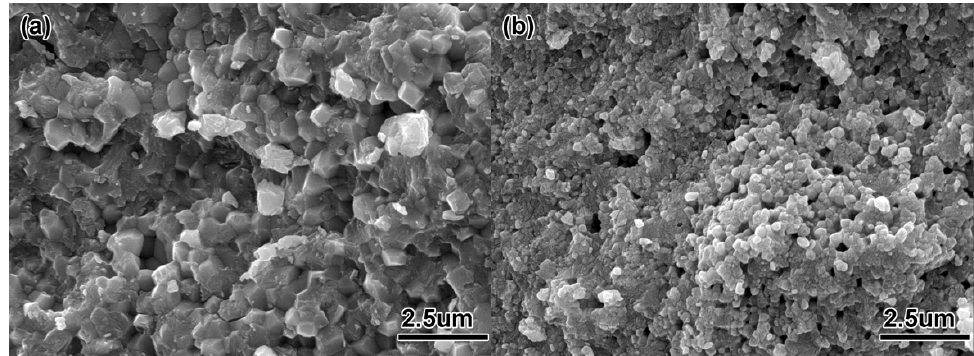
Figure 14. SEM micrographs of the fracture surfaces for sintered ZrO 2 samples ( a ) fracture surfaces using 200 nm powders, ( b ) fracture surfaces using 100 nm powders.